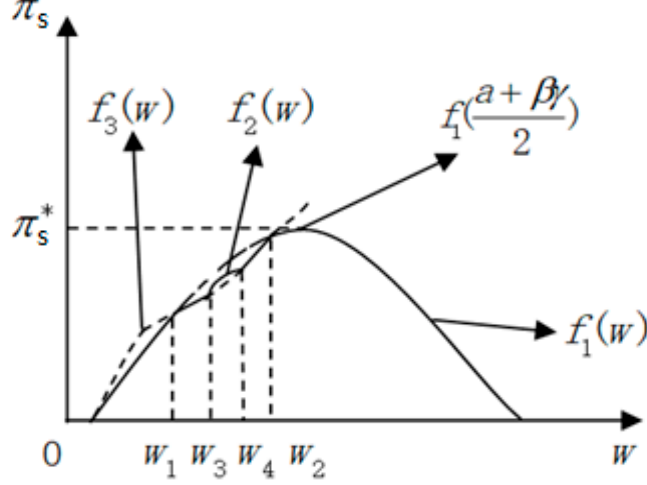
Figure A1. The schematic profit function of the supplier for Case A5.